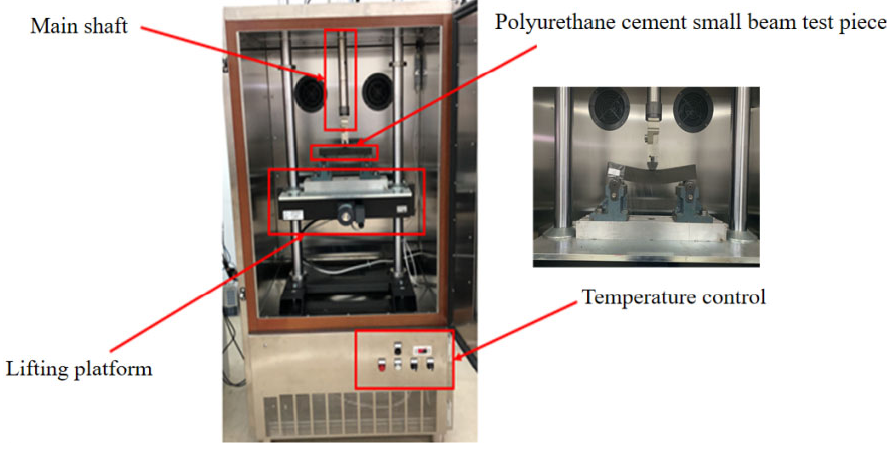
Figure 19. UTM ‐ 30 testing machine loading device. Figure 19. UTM-30 testing machine loading